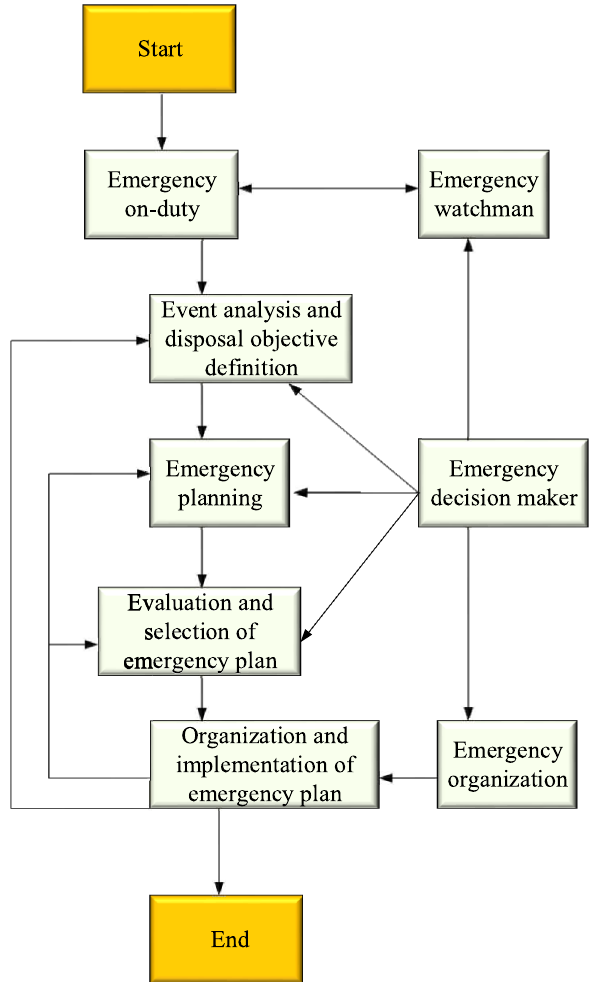
Figure 2. Sequence diagram of public emergency decision-making